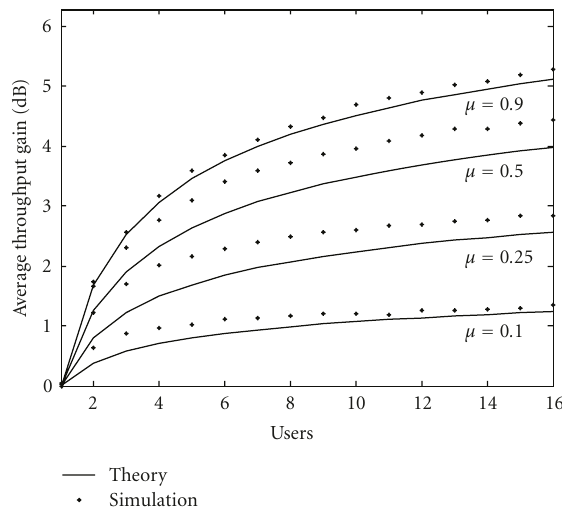
Figure 3: Throughput enhancement using threshold-based mul- tiuser scheduling in WiMAX OFDMA (16 users per BS